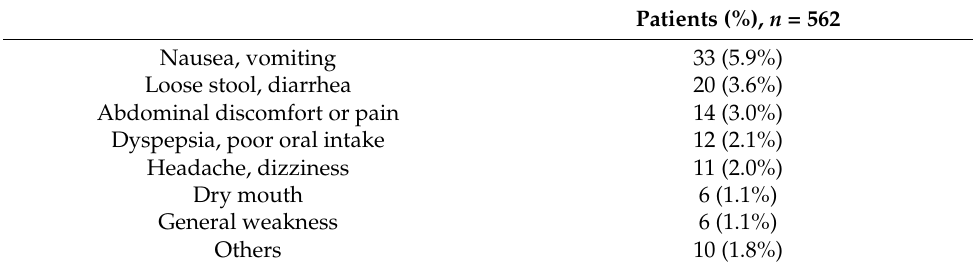
Table 4. Adverse events during quadruple